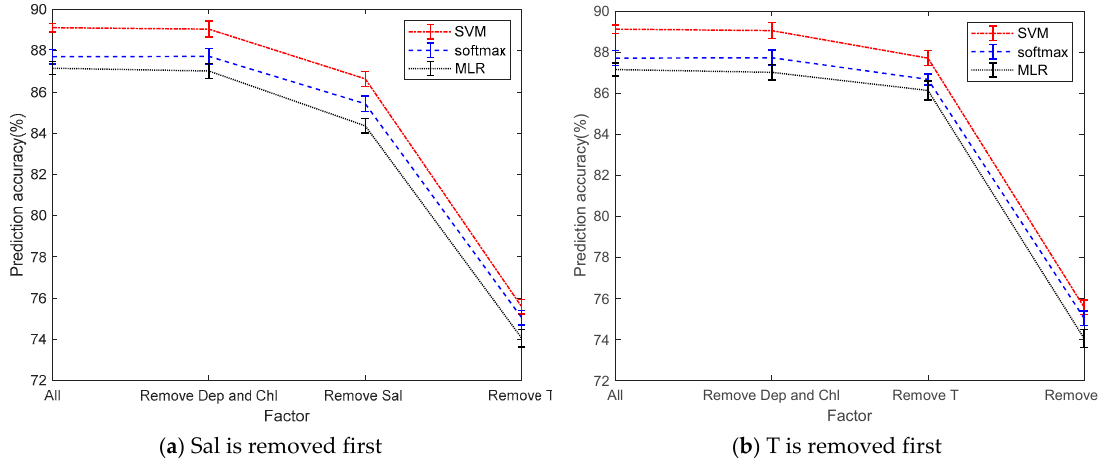
Figure 10. Prediction accuracy after simplifying the model.